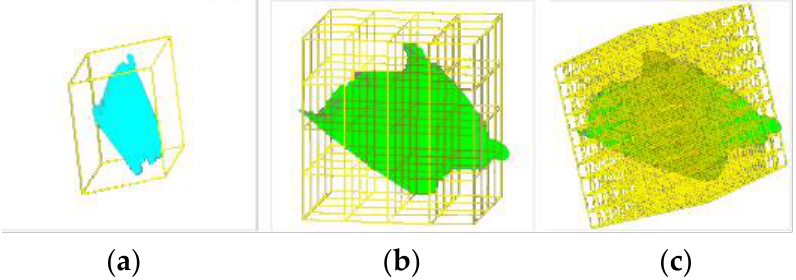
Figure 14. Octree subdivision renderings. ( a ) A minimum enclosing frame of the point cloud; ( b ) the split times equal to 2; ( c ) the split times equal to 3.